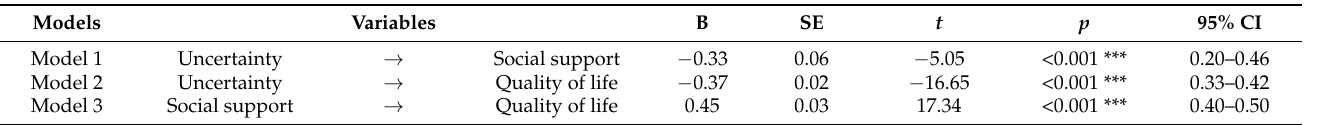
Table 3. Mediating effect of social support on the relationship between uncertainty and quality of life (n = 155).